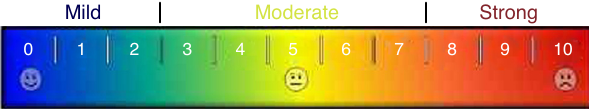
Figure 4 Visual color scale used to score the sialadenitis symptoms.